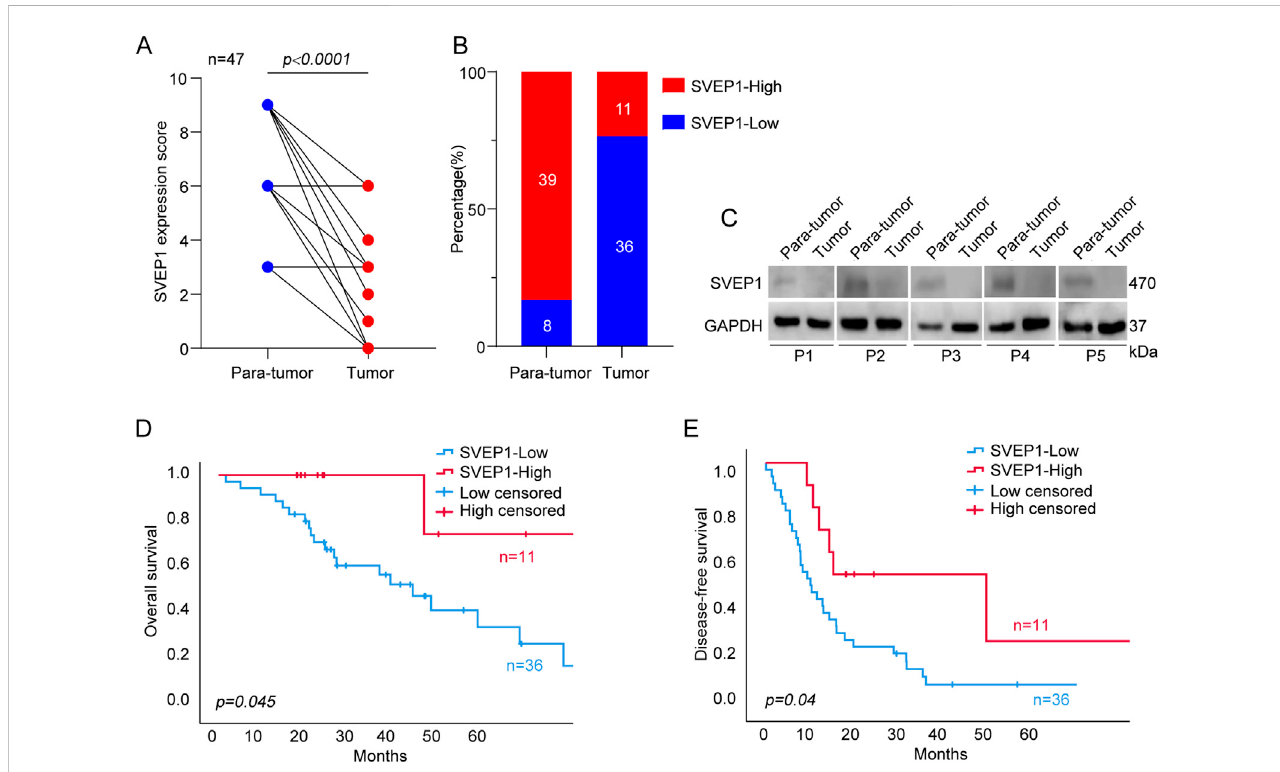
FIGURE 1 The expression pattern of SVEP1 in ICC and its correlation with prognosis. (A) The SVEP1 expression level based on the IHC score in tumor tissues comparedwithpairedadjacentnormaltissues. (B) TheproportionofhighandlowexpressionofSVEP1intumortissuescomparedwithpairedadjacentnormal tissues. (C) ThelevelofSVEP1proteinamong fi vepairsofpara-tumorandtumorbywesternblotassay. (D – E) Kaplan-MeieranalysiscomparingOS (D) andDFS (E) in the ICC patients with high and low expression of